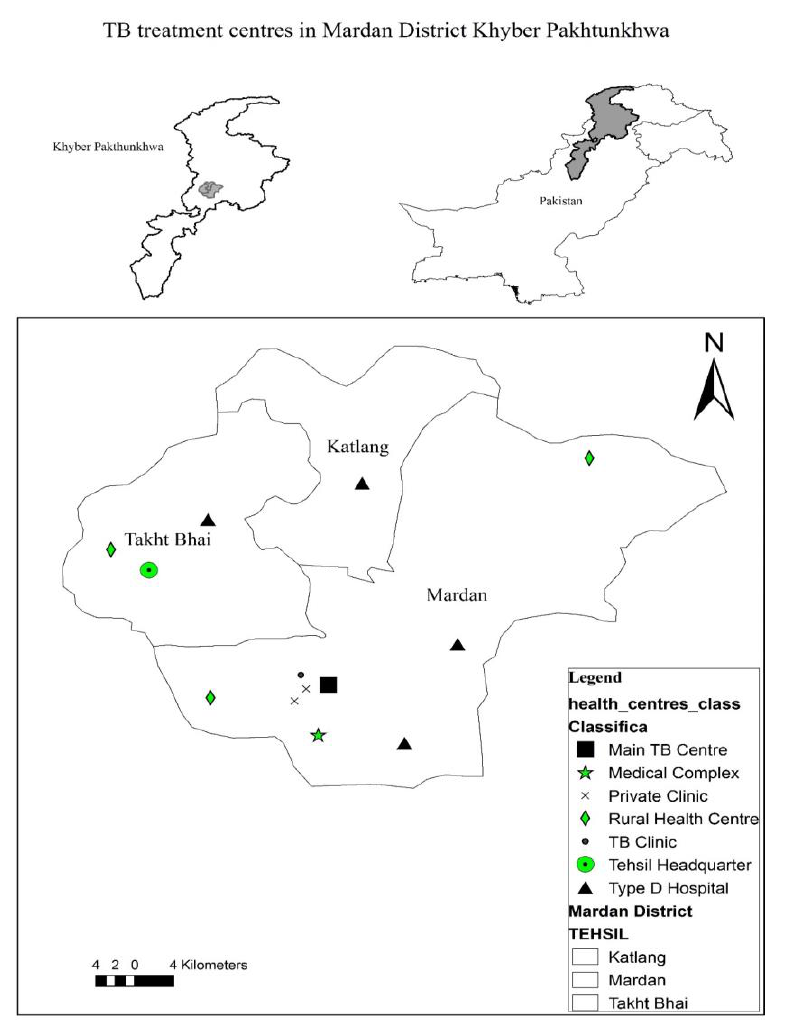
Figure 3. DOTS Facilities Post-2012 .